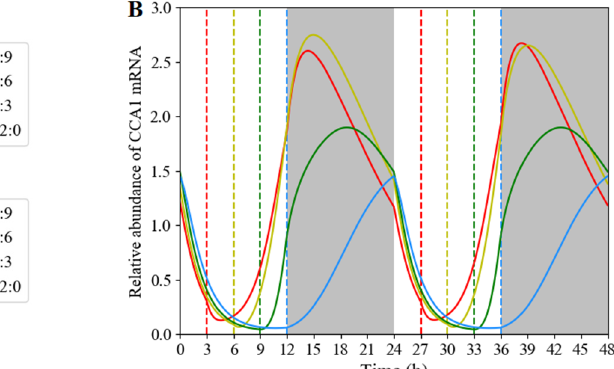
( A ) and L:R = 3:9 (red vertical dashed lines in panel ( B ) represent 3 h red light/9 h white light/12 h white light/9 h red light/12 h dark in a diurnal cycle. R:L = 6:6 (yellow vertical dashed lines in panel